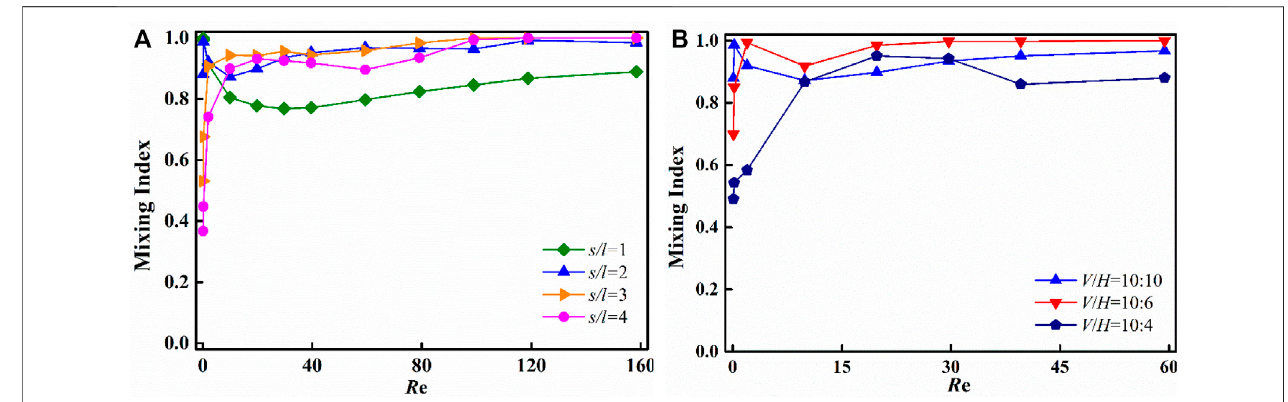
FIGURE 11 | Effects of s / l and V / H on mixing performance at different R e: (A) s / l ( l (cid:1) 1 mm, V/H (cid:1) 10:10, V (cid:1) 10 mm) and (B) V / H ( l (cid:1) 1 mm, s / l (cid:1) 2, V (cid:1) 10